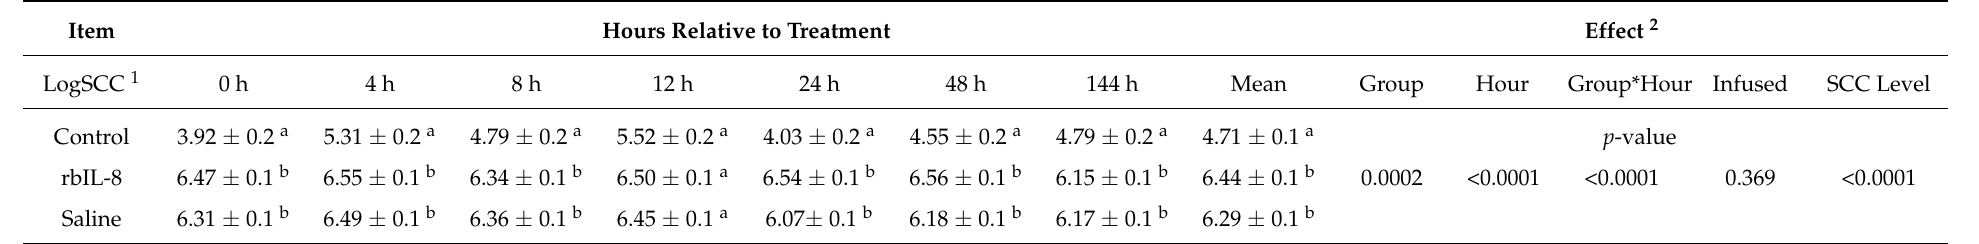
Table 2. The log of the somatic cell count (SCC) per mL concentrations relative to